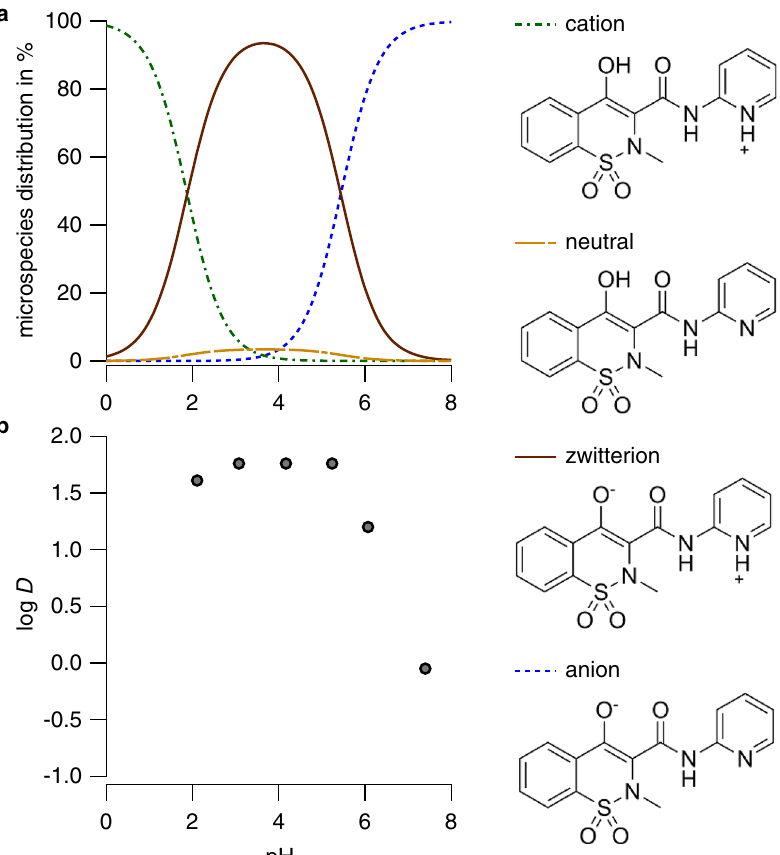
Fig. 4 The chemical Piroxicam has four different speciations. a All potential speciations of Piroxicam are shown for a pH range from 0 to 8, the fractions of the ionic species dominate over the whole range of pH values. The p K a predictions of JChem suggest that a dianion as additional species should be present at pH values > 12 (this species cannot be con fi rmed by p K a measurements due to experimental limitations, the dianion is therefore not included in the plot). b The experimentally determined log D values of Piroxicam vary at different pH values. Experimental micro-p K a s and log D were taken from Tsai et